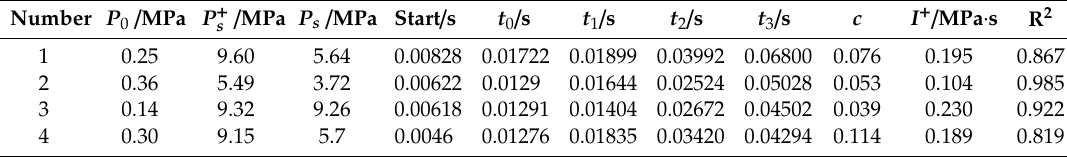
Table 2. Gives the fourth test pressure–time history parameter tables.